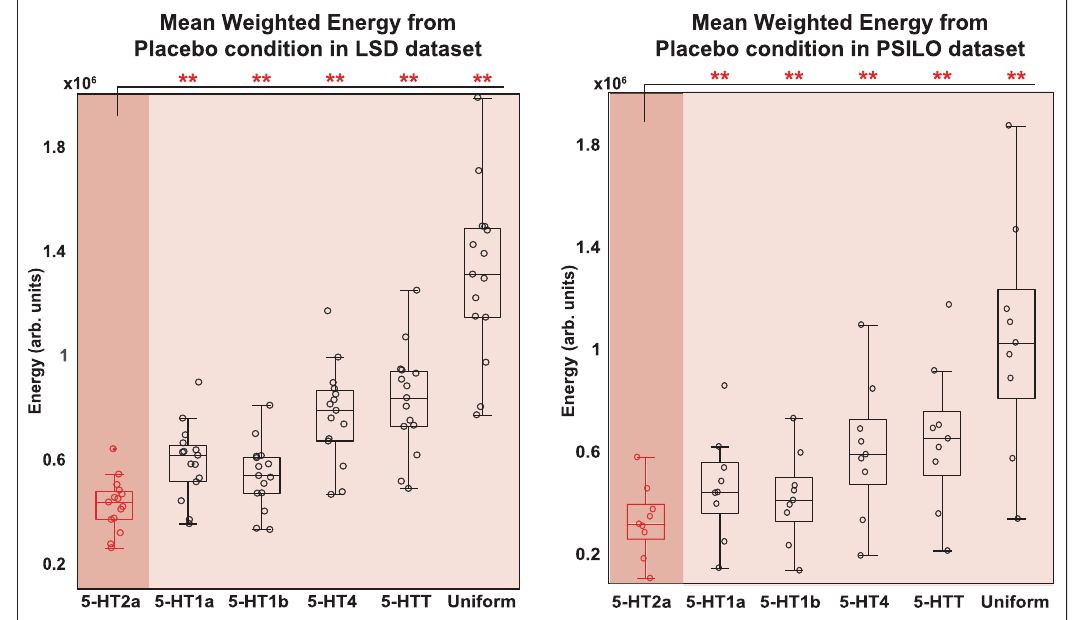
Fig. 5 | The serotonin 2a receptor fl attens the control energy landscape more thananyotherreceptortested. We weighted ourmodelwithexpressionmapsof other serotonin receptors (5-HT1a, 5-HT1b, and 5-HT4), and the serotonin trans- porter (5-HTT), and found that 5-HT2a resulted in signi fi cantly lower transition energy(averagedacrossallpairsofstates)thanallothers.(left)Energiescalculated from each subject ’ s placebo centroids in the LSD dataset ( n =15). (right) Energies calculated from each subject ’ s placebo centroids in the psilocybin dataset ( n =9).